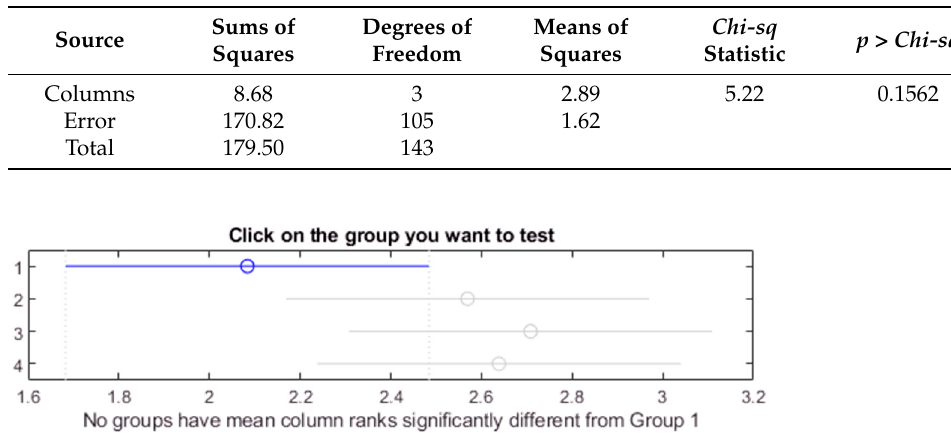
Figure 23. Post hoc Bonferroni test for oil Midel 1204 with different concentrations of surfactant oleic acid.